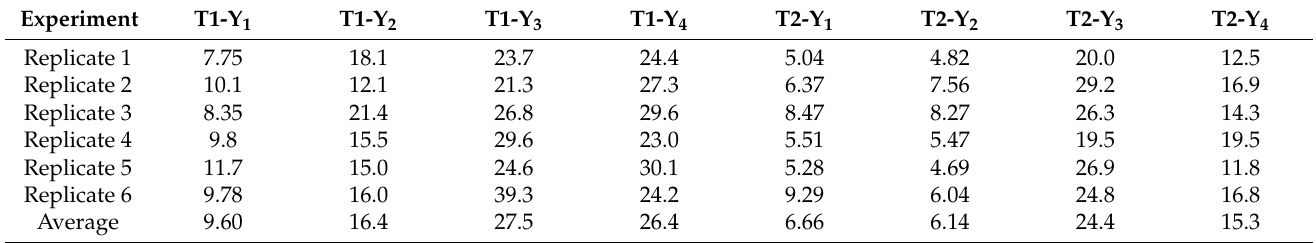
Table 6. Hg 2+ concentrations ( µ g/L) in test 1 and test 2 for all experiments, six replicates for each